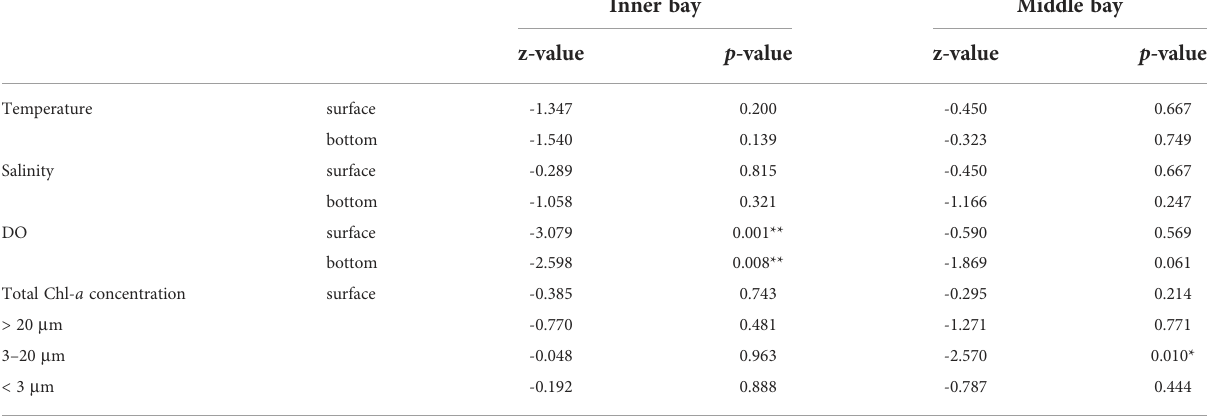
TABLE 1 Spatial differences in environmental variables were tested with Mann-Whitney